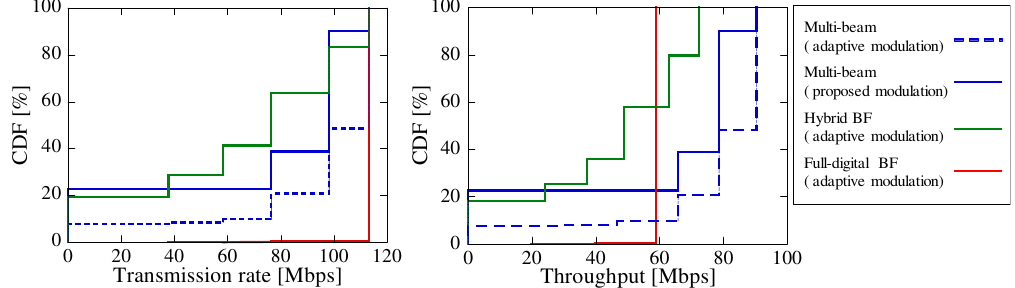
Figure 9. Characteristics of transmission rate and throughput under